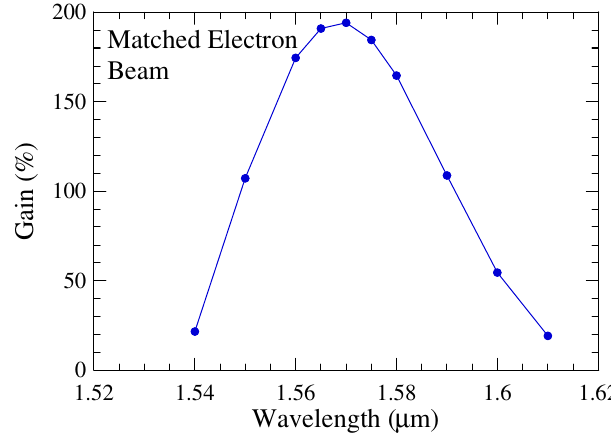
FIG. 1. (Color) Gain spectrum for a matched beam in a two- plane focusing